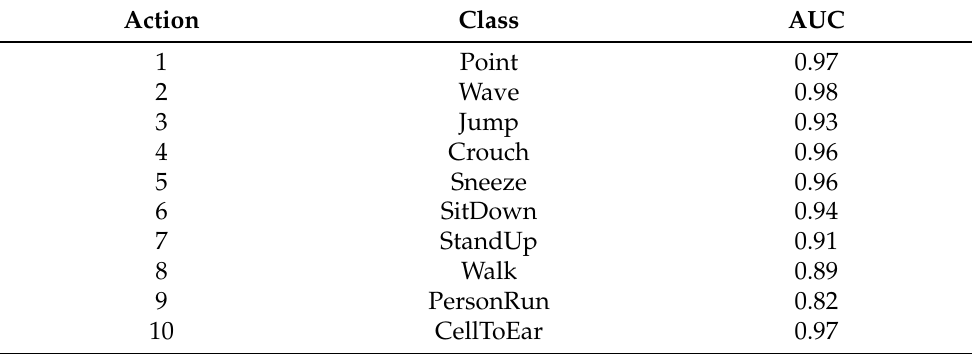
Table 6. The area under the curve as per class on MCAD dataset with EFS